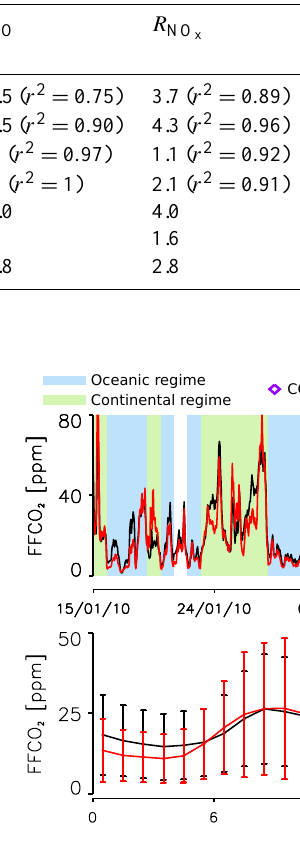
Fig. 7. Top: time series for FFCO 2 during the MEGAPOLI cam- paign calibrated using CO and NO x as proxies. The purple rhom- buses correspond to the CO 2 ff from the flasks sampling. Periods during which the air masses originate from the west are highlighted in blue, and periods during which the air masses originate from the east are highlighted in green. No colour is attributed on the days without a clear air mass origin (see Fig. 2). Bottom: mean diur- nal cycles of FFCO 2 (CO) in black and FFCO 2 (NO x ) in red at the LHVP station from 15 January 2010 to 19 February 2010.